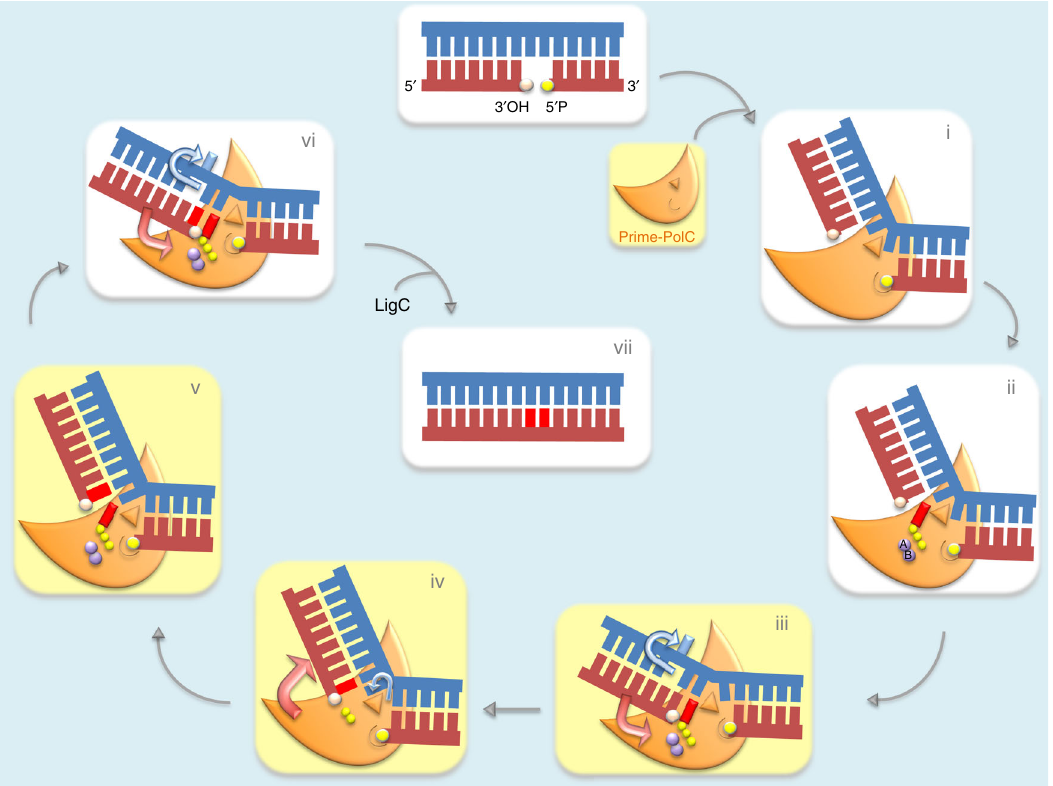
Fig. 7 Proposed mechanism of gap-repair synthesis by Prim – PolC. Schematic diagram representing the elucidated Prim – PolC catalytic intermediates (yellow boxes) and their positions in the catalytic cycle. (i) Gapped DNA with a 3 ′ -OH and 5 ′ phosphate is bound by apo Prim – PolC (PDBID: 5OP0). (ii) Upon binding, the 5 ′ phosphate is located in the binding pocket, and the hydrophobic wedge residues I73/Y74 splay the DNA via insertion between the unpaired bases. (iii) The binary complex then binds an NTP, the DNA splay angle decreases as the upstream DNA docks onto Loop 3 and is tethered via the insertion of the pin residue (N321) that, with P320, disrupts the base pairing at position − 2 (PDBID: 6SA0). A process of Synthesis-dependent Template Displacement (STD) allows the ternary complex to be formed. (iv) Nucleotidyl transfer proceeds leaving PPi in the active site, and the extension process pulls the remaining unpaired base into the templating position. The extended upstream duplex disengages from Loop 3 and with an increase in splay angle (PDBID: 6SA1). (v) The gating residue (R179) moves into an open conformation, PPi leaves the active site and is replaced by the next incoming NTP. (vi) The DNA splay angle decreases as the upstream DNA docks onto Loop 3 and is tethered via the insertion of N321 that disrupts the base pairing at position − 2. Another ternary complex is formed. (vii) Following nucleotidyl transfer, the upstream duplex disengages from Loop 3, and the downstream DNA disengages from the phosphate-binding pocket, leaving a nick that is then ligated by LigC to complete repair of the